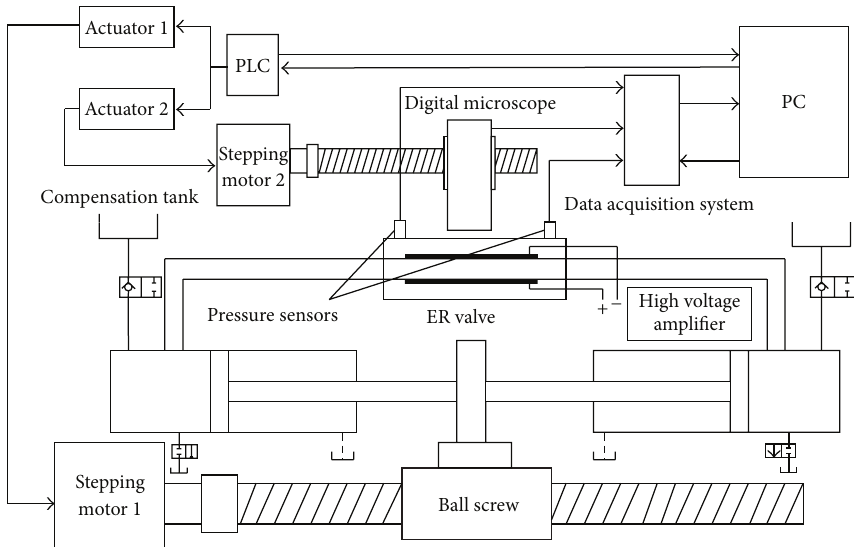
Figure 1: Schematic diagram of the experimental